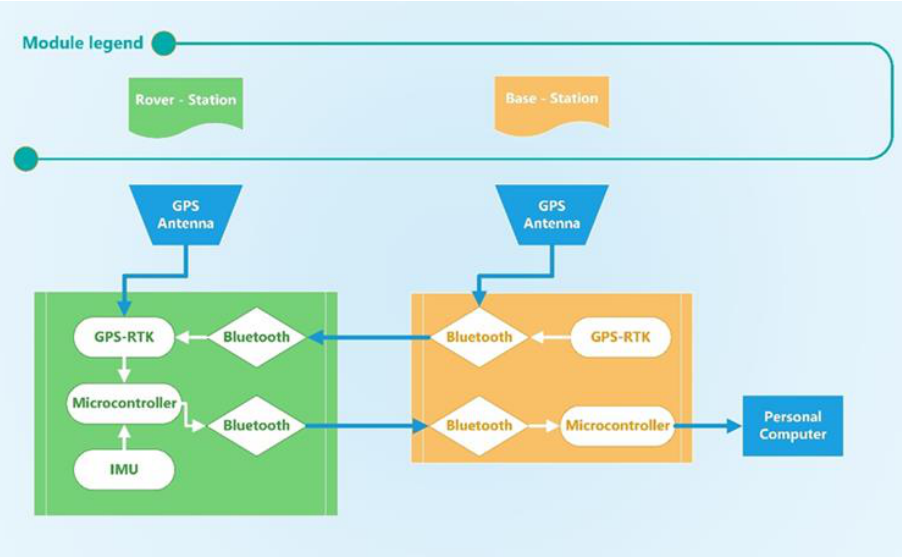
Figure 2. Block diagram of the proposed hardware